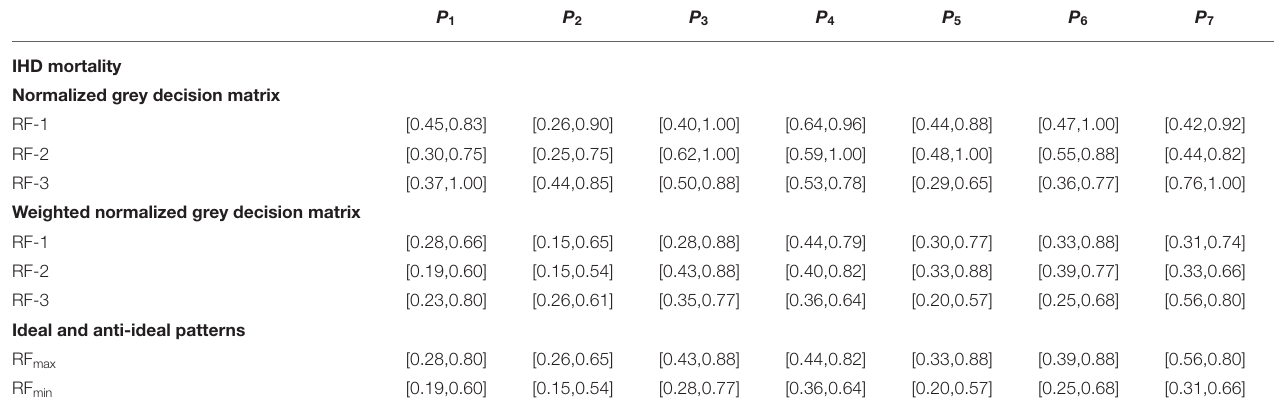
TABLE 6 | Estimated distances of the alternatives (RF h ) from the ideal and anti-ideal pattern. D +